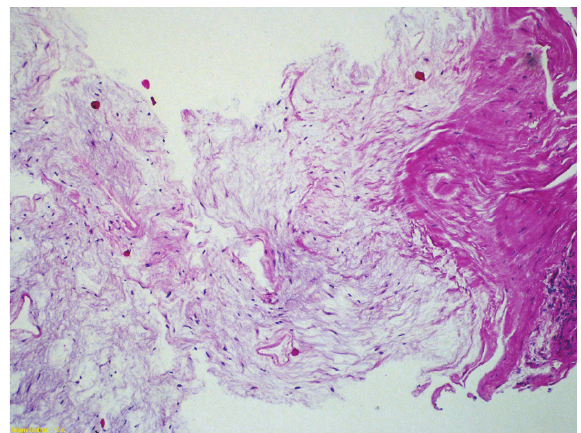
Figure 5: On histological examination, abundant myxoid matrix with few cells is observed. Notice the poor vascularization. Normal adjacent skeletal muscle is present on the left side of Figure 4.